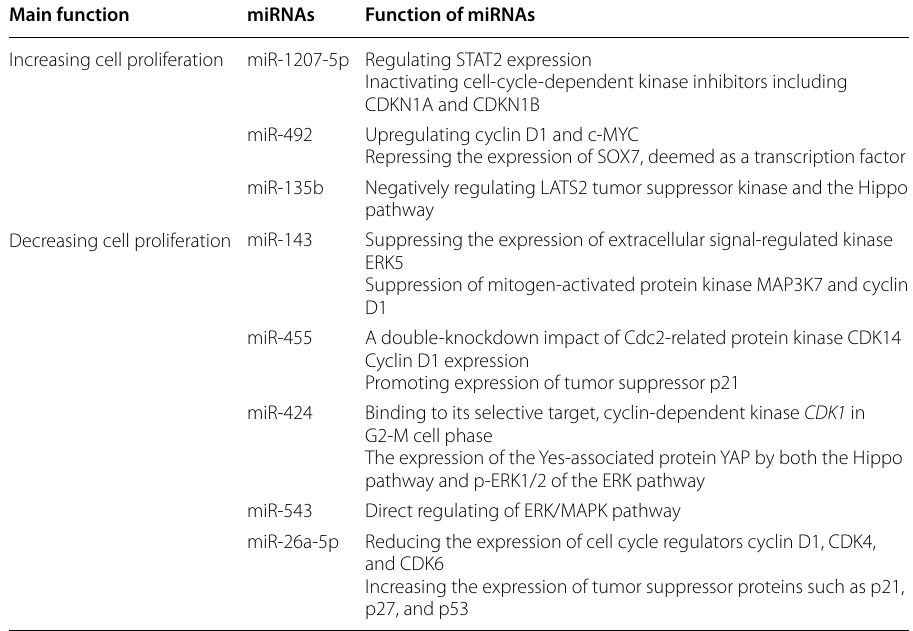
Table 2 Role of miRNAs in pathogenesis by either increasing or decreasing cell proliferation [46] Main